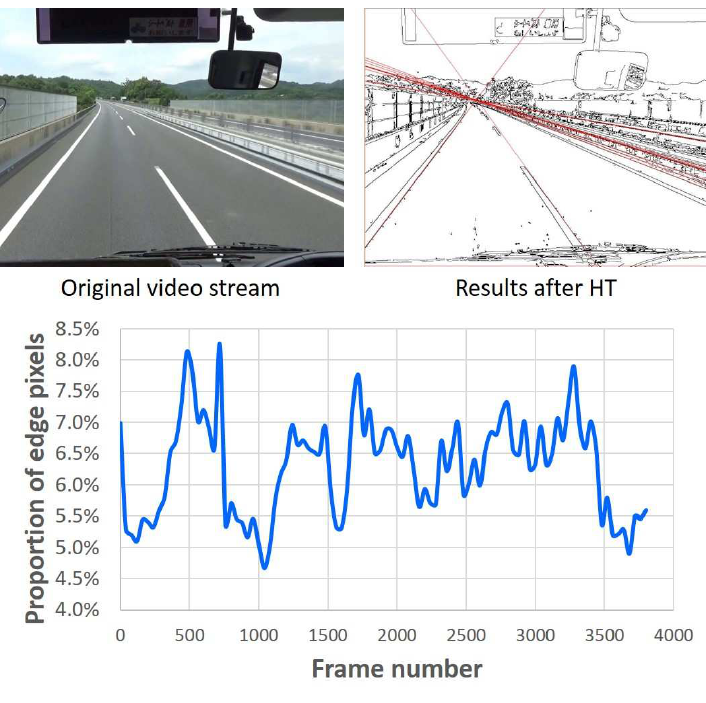
Figure 8. Analysis of the proportion of edge pixels in a highway